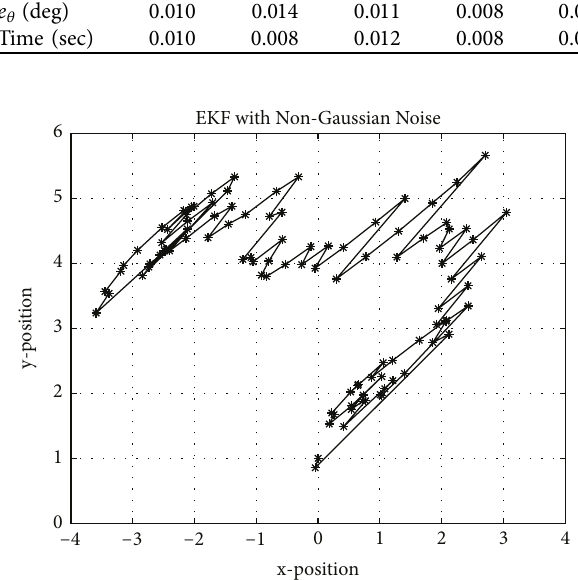
Figure 4: WMR’s state with the EKF (one landmark and non- Gaussian noise).